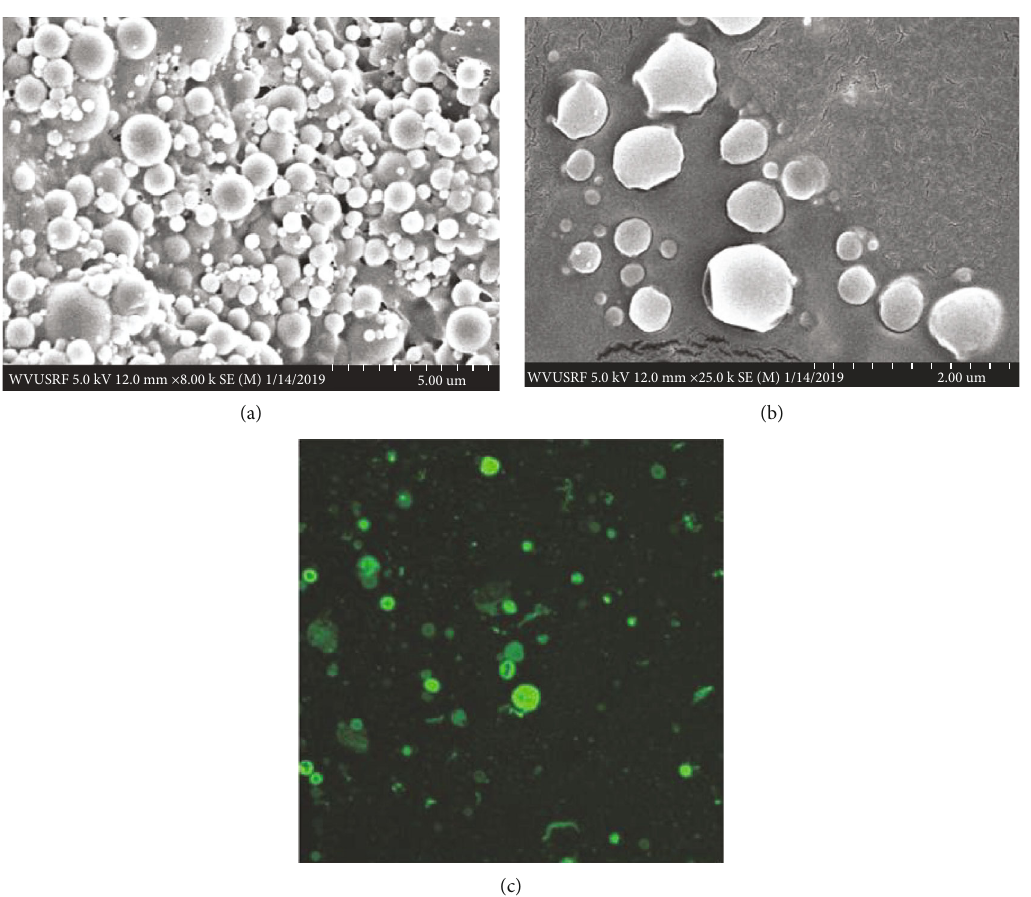
Figure 2: (a, b) Scanning electron microscopy (SEM) images of lyophilized recombinant mouse IL-12- (rmIL-12-) loaded PLGA nanospheres at 8000x and 25000x magni fi cations, respectively. (c) Fluorescein isothiocyanate- (FITC-) conjugated bovine serum albumin (BSA) was loaded into poly(lactide-co-glycolic) acid (PLGA) nanospheres, and the product was visualized for protein incorporation through confocal microscopy.